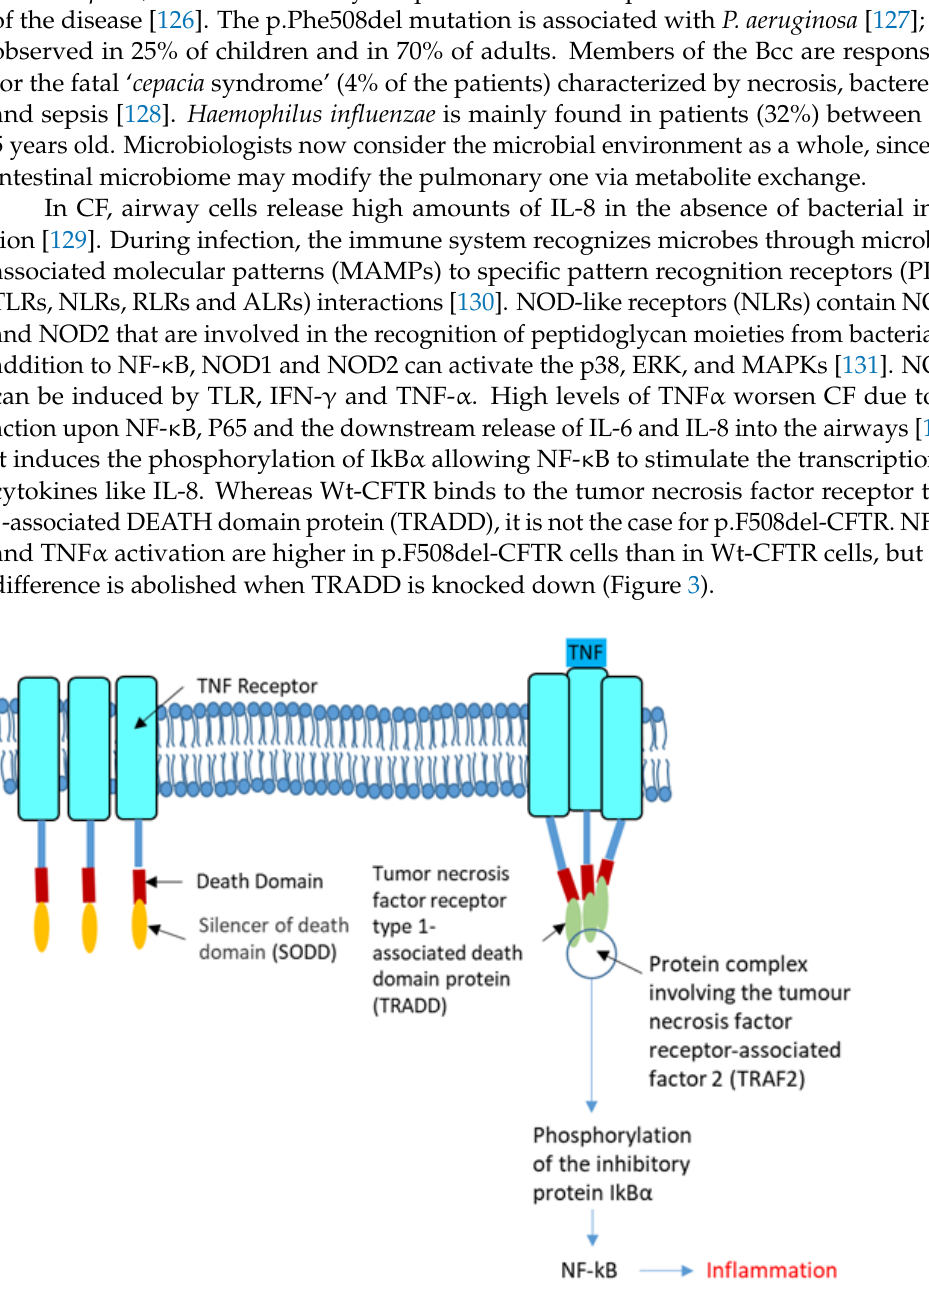
Figure 3. The tumor necrosis factor receptor. The tumor necrosis factor receptor (TNFR, left) is a cytokine receptor characterized by its ability to bind the tumor necrosis factors (TNFs). This binding occurs via an extracellular cysteine-rich domain. It has a death domain involved in the regulation of apoptosis and inflammation through their activation of caspases and NF- κ B. In the strict sense, the term TNF receptor is used to refer to the archetypal members of the superfamily, namely TNFR1 which recognize TNF- α . Its SODD (silencer of death domains), suppresses TNF-induced cell death and NF- κ B activation. Most of the TNF receptors need a specific adaptor protein such as TRADD for downstream signaling (Right). TRADD is an adaptor molecule that interacts with TNFR1 and mediates NF- κ B activation. The tumor necrosis factor receptor-associated factor 2 (TRAF2) is required for TNF-alpha-mediated activation of MAPK8/JNK and NF- κ B. The configuration shown in the right panel permits the phosphorylation of the inhibitory protein IkB α that favors the activation of NF-kB.